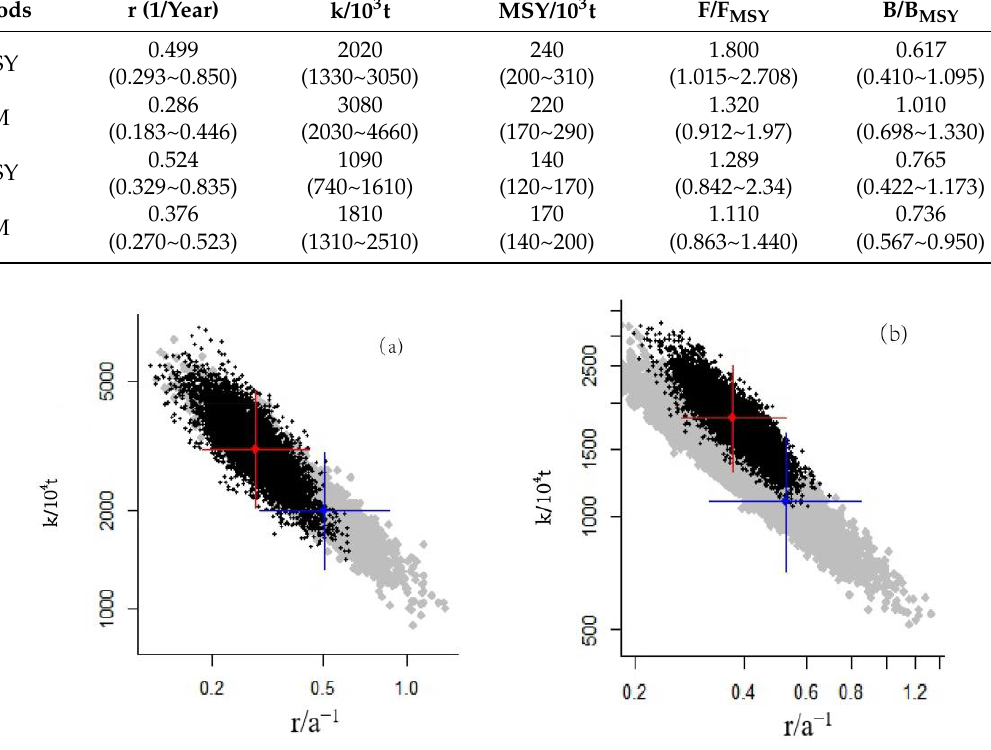
area is the r–k pair that satisfies CMSY, and the blue cross is used to mark the best r–k pair of CMSY Figure 2. Viable r – k pairs for Mackerel_ECS ( a ) and Conger_ECS ( b ) from CMSY and BSM. The grey and its 95% confidence interval. The black region is the r–k pair satisfying the BSM, and the best r–k area is the r – k pair that satisfies CMSY, and the blue cross is used to mark the best r – k pair of CMSY pair and its 95% confidence interval are marked by the red and its 95% confidence interval. The black region is the r – k pair satisfying the BSM, and the best r – k pair and its 95% confidence interval are marked by the red cross.